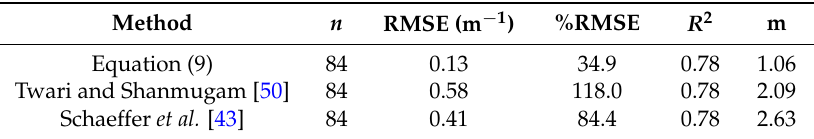
Figure 8. Scatterplot of a cdom 412 absorptions derived from Equation (9) and published models using spectral data and measured absorptions from NB (1990–2000, 2005), SJB (2010), and PB (2011). Table 5. Comparison of statistical results of a cdom 412 absorptions derived from Equation (4) and published models using spectral data and measured absorptions from NBE (1990–2000, 2005), SJBE (2010), and PBE